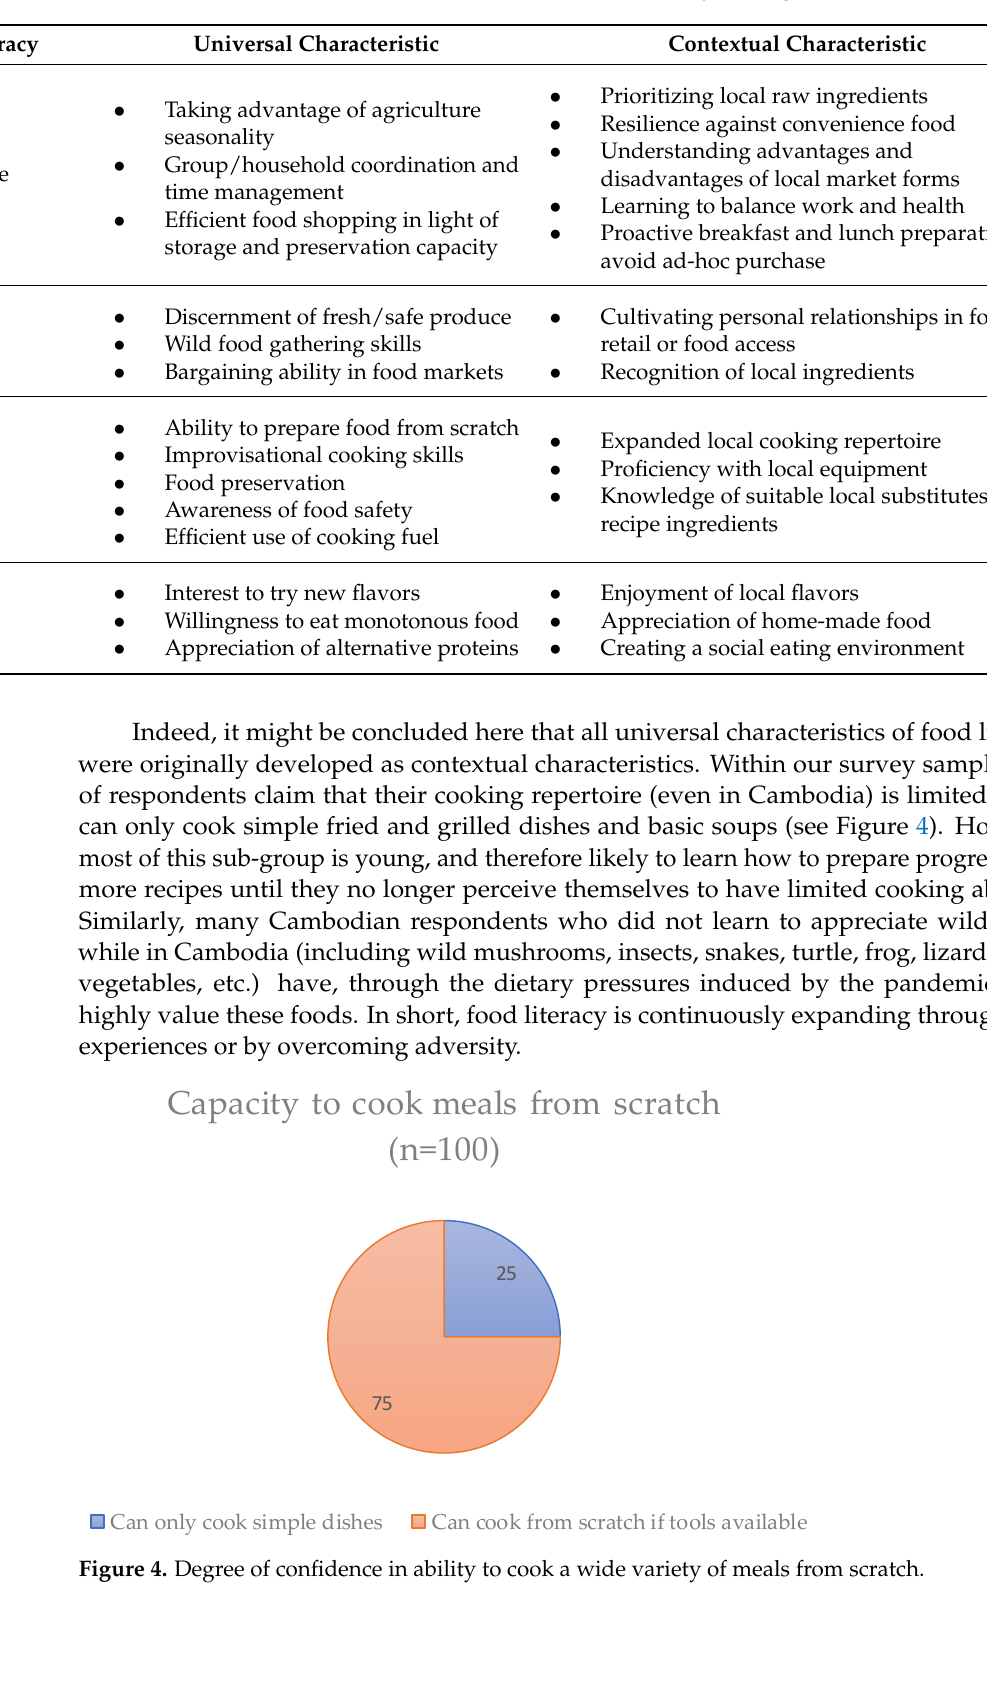
Table 2. Universal and contextual characteristics of food literacy for migrants in Thailand.